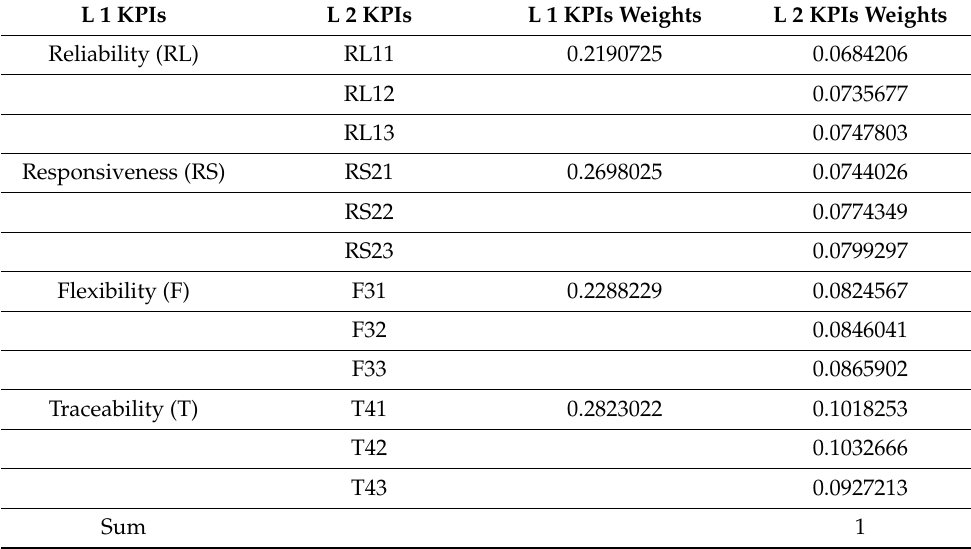
Table 5. Net weights for levels 1 and 2 KPIs for scenario 2.